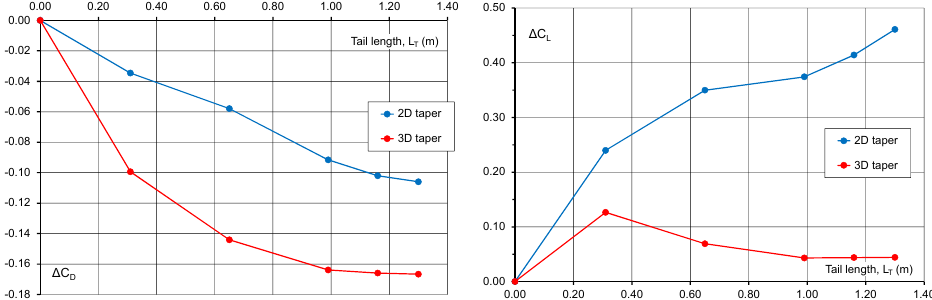
Figure 6. Drag coefficient reduction, ( left ), and lift coefficient increase, ( right ), from adding the tapered tail.